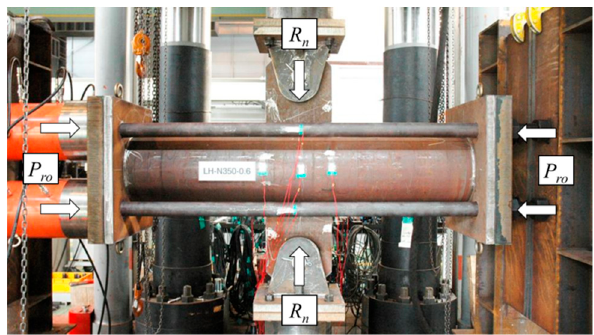
Figure 2. LH-N350-0.6 specimen (LH is the longitudinal horizontal plate, N350 is the plate width, and 0.6 is the utilization ratio).